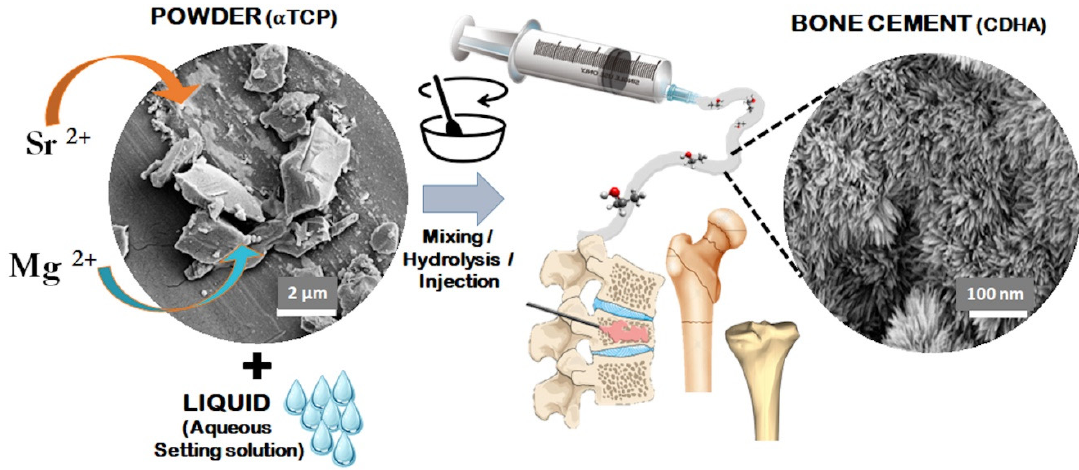
Figure 2. Scheme showing the mechanism of formation of apatitic bone cements and their applicability in bone regener- ation.